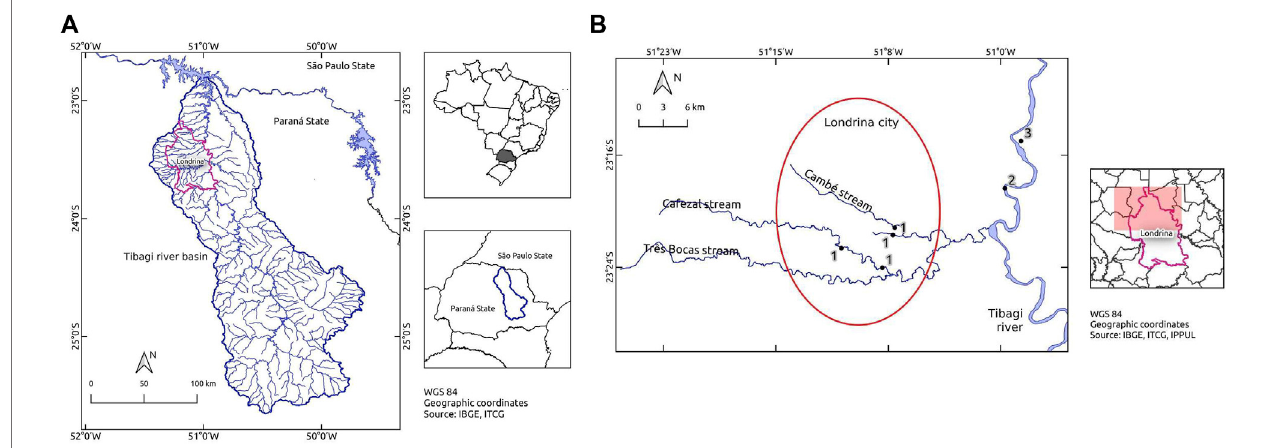
FIGURE1| Map ofTibagiriverbasin and Tibagi River location indicating:1) Sewage treatment plants (23 o 21 ′ 23´´ e51 o 07 ′ 03´´;23 o 21 ′ 52´´e 51 o 07 ′ 11´´, 23 o 22 ′